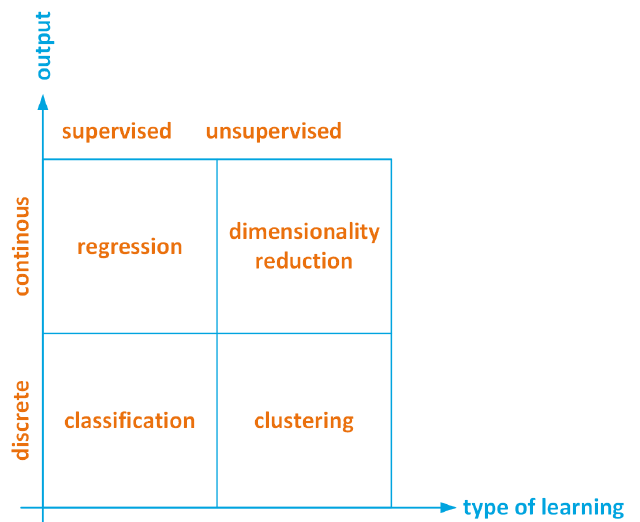
Figure 3. Types of learning and ML classes of